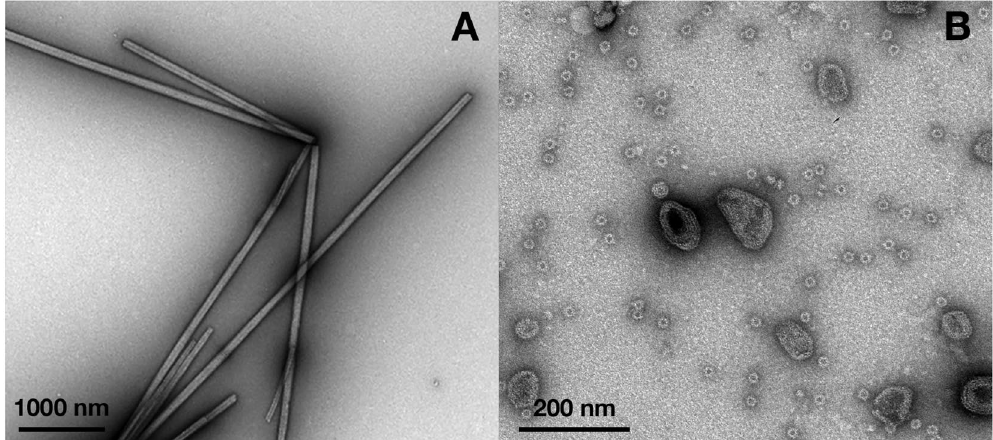
Figure 2. In vitro assembly of RSV CA at near-physiological temperatures. To promote assembly, purified RSV CA (600–700 μ M in standard neutral pH storage buffer) was dialyzed against the same buffer, with variation of the NaCl concentration (25–1500 mM). Dialysis was carried out at a fixed temperature of 37 °C. The figure shows transmission electron micrographs of typical assembly products, negatively stained with uranyl acetate. ( A ) Low salt concentrations (25–150 mM) promote the exclusive formation of CA tubes. ( B ) Elevated salt concentrations (1500 mM NaCl) promote formation of CLPs and icosahedral